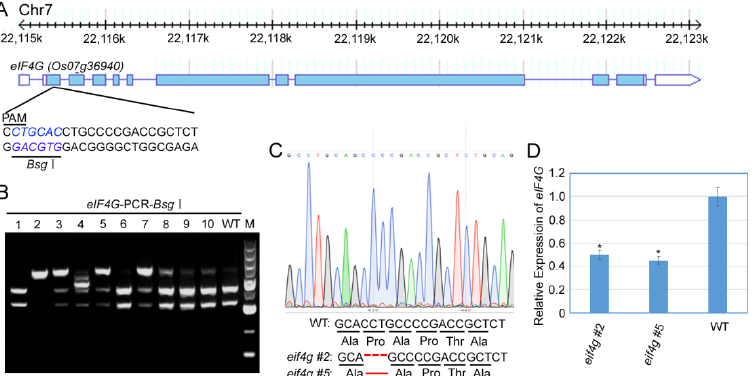
Figure 1. Genomic editing of rice eIF4G by CRISPR/Cas9. ( A ) Schematic diagram of the CRISPR/Cas9 target sites in eIF4G . The sgRNA target sequences are shown in black letters, and Bsg I digestion sequences are shown in blue letters. ( B ) Mutation analysis of 10 T0 transgenic lines by Bsg I digestion of PCR fragments. ( C ) DNA and amino acid sequence analysis of mutated alleles identified from cloned PCR fragments of two representative T1 transgenic lines. DNA and amino acid deletions are denoted by red dashes. ( D ) qRT – PCR analysis of eIF4G mRNA transcription levels in mutants and WT rice plants. Signal intensities for each transcript were normalized to those for UBQ. All data are means ± SD ( n = 3).The statistical significance of the difference between the eif4g mutant lines and wild-type plants was determined using Student ’ s t -test. * p < 0.05.